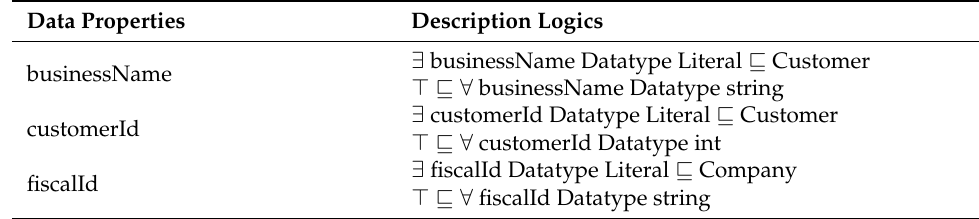
Table 3. Data properties of class Customer.